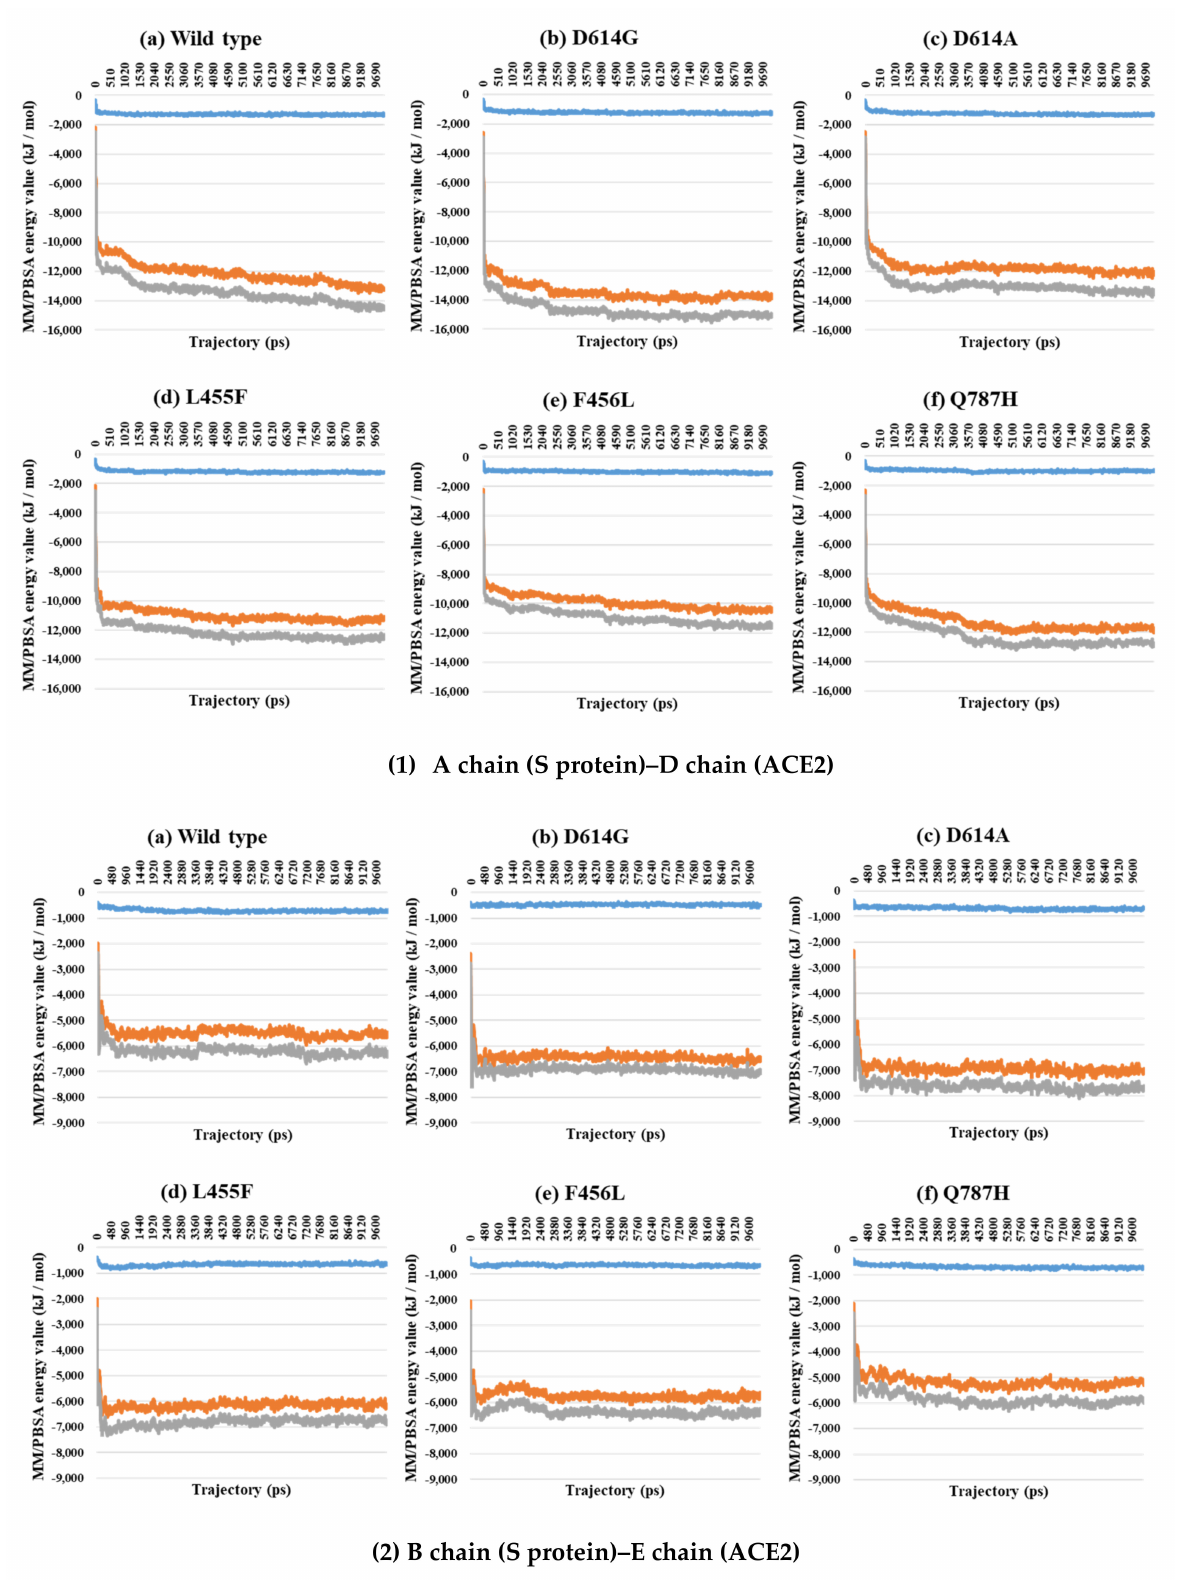
Figure 6. MM/PBSA results for A–D (1) and B–E (2) depending on the MD trajectories in the 2-open-complex form (7A97). ( a ) Wild type, ( b ) D614G, ( c ) D614A, ( d ) L455F, ( e ) F456L, and ( f ) Q787H. The X axis denotes trajectory (ps), and the Y axis denotes the MM/PBSA energy value (kJ/mol). Blue color indicates van der Waals energy between S protein and ACE2, orange color indicates electrostatic energy, and gray color indicates total